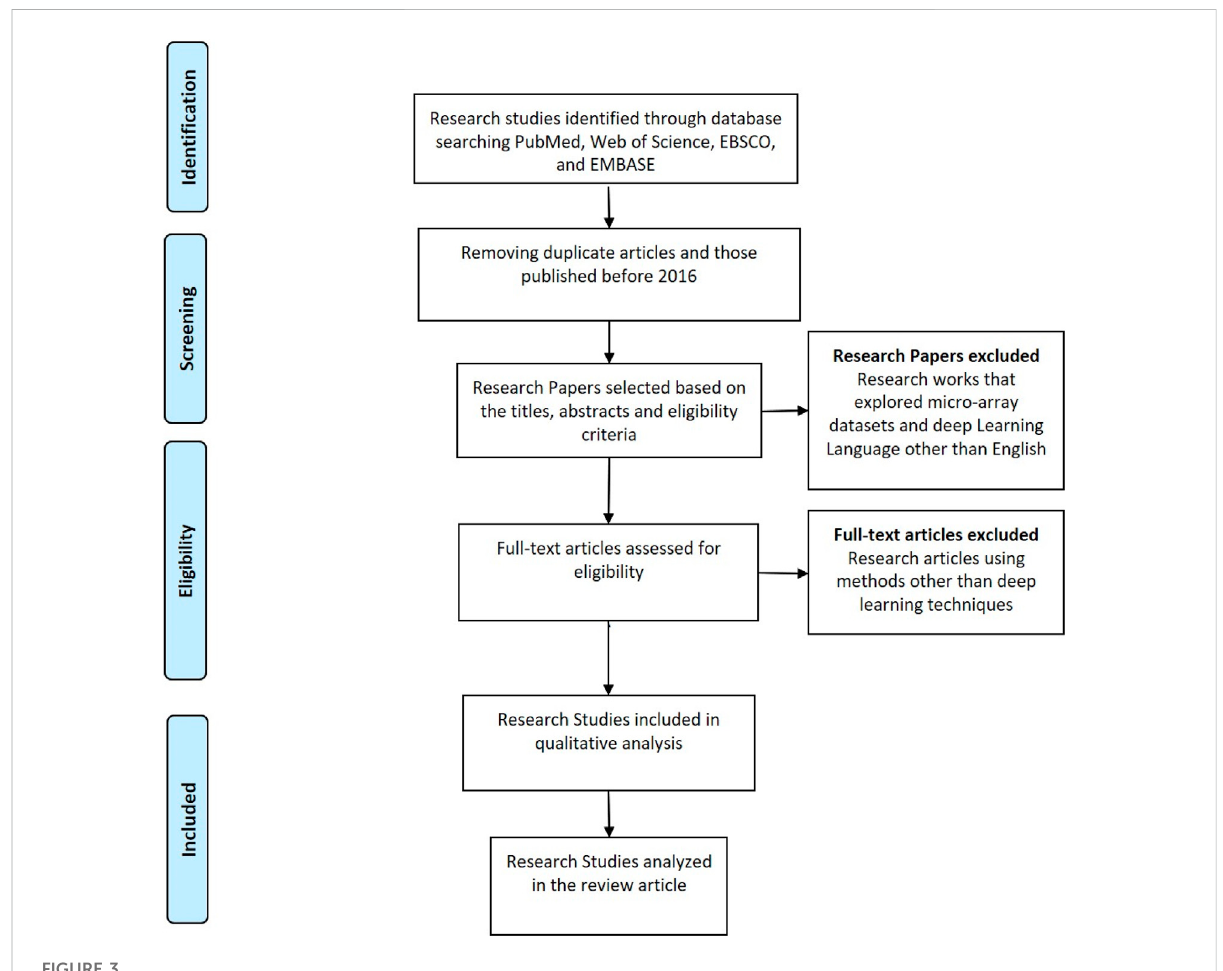
FIGURE 3 Prisma search strategy.